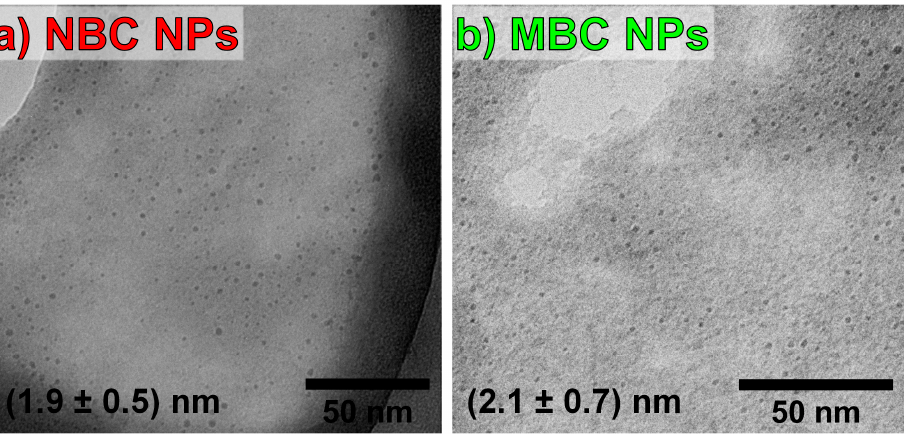
Figure 2. TEM images of ( a ) NBC and ( b ) MBC NPs produced by performing the procedure depicted in Figure 1 and described in the Materials and Methods section.